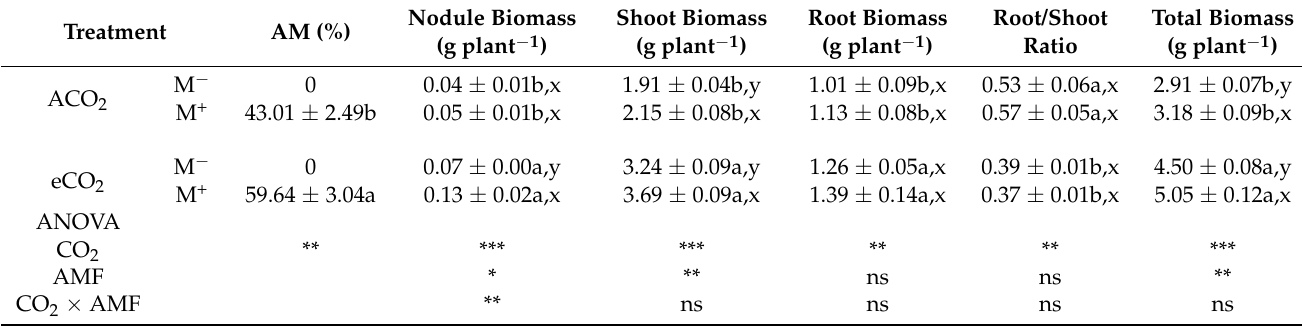
Table 1. Percentages of arbuscular mycorrhizal (AM) colonization, nodule biomass production, shoot biomass production, root biomass production, root/shoot ratio, and total biomass production in Funneliformis mosseae inoculated faba beans grown for 12 weeks at ambient CO 2 (ACO 2 ) and elevated CO 2 (eCO 2 ).